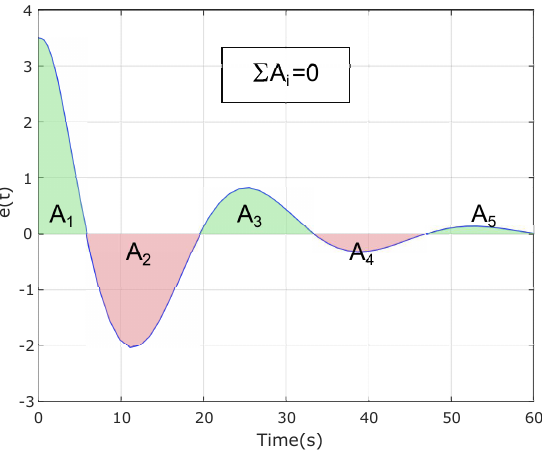
Figure 16. Error of a system formed by a linear controller with a double integrator